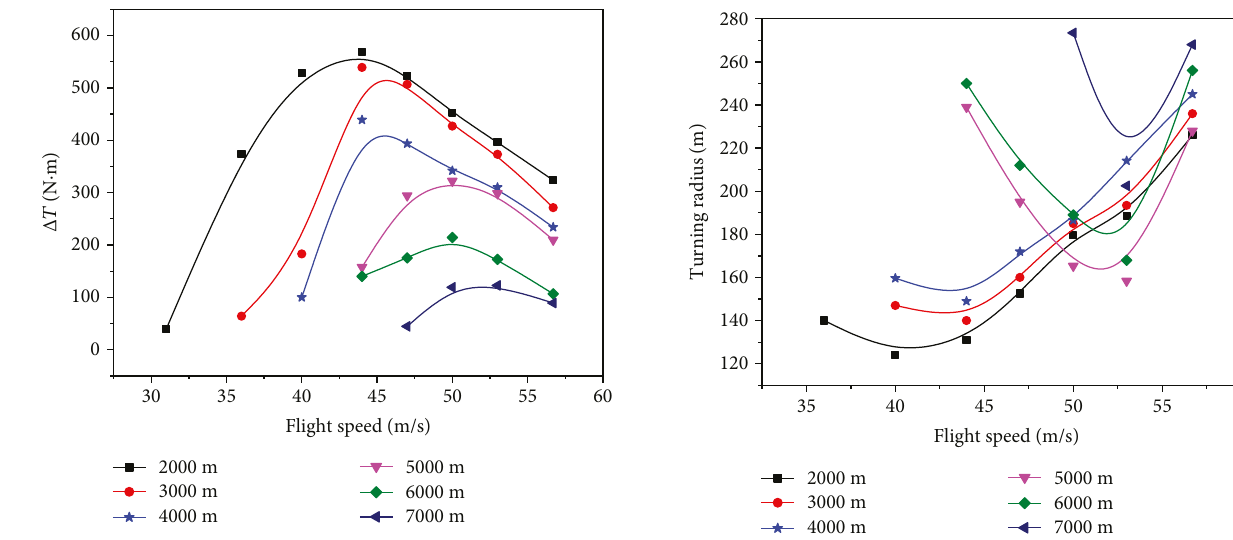
Figure 15: Turning radius of UAV at di ff erent